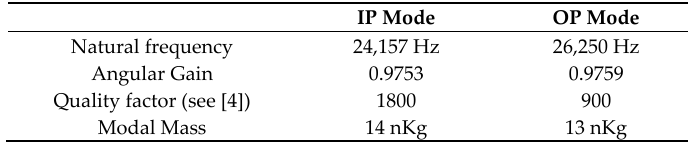
Figure 1. ( a ) Schematic view of the proposed FM pitch gyroscope. The actuation and detection schemes for the IP mode is also shown; ( b ) The first two modes of the structure: the contour of the displacement field is shown in color; ( c ) Optical microscope image of a fabricated FM pitch gyroscope. Table 1. Mechanical properties of the proposed FM pitch gyroscope computed through finite element (FE) simulations.